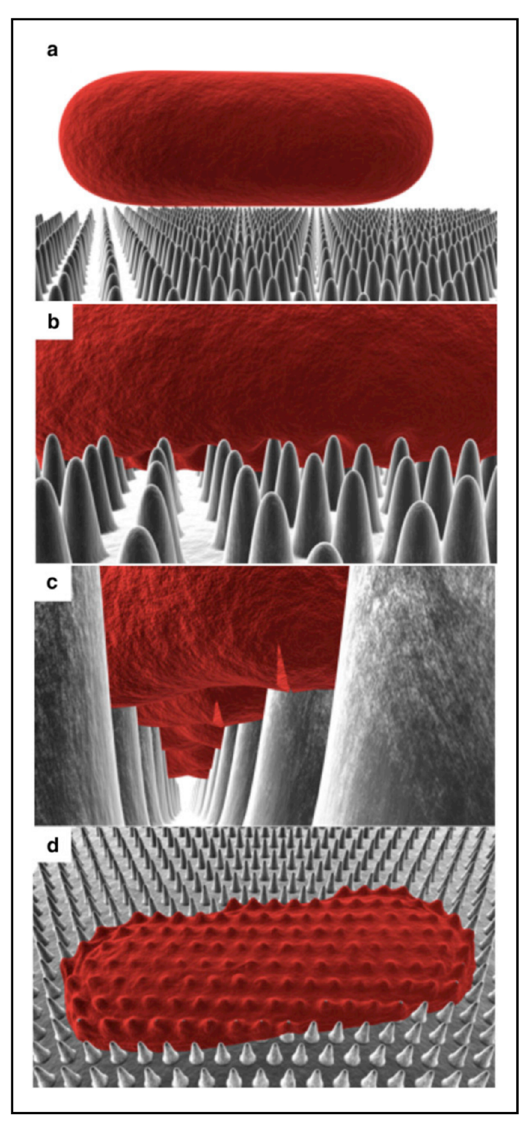
Figure 16: Schematicillustrationofthe mechano - bactericidalfunction of the surface. ( a ) Contacts of a bacteria cell with the wing nanopillar surface. ( b ) Adsorption of the membrane to the surface protrusions leads to stretching of the cell membrane. ( c ) Gradual progress of adsorption leads to broad stretching at the contact regions and ulti - mately ( d ) cell death [ 122 ] . Copyright 2013, Elsevier ™